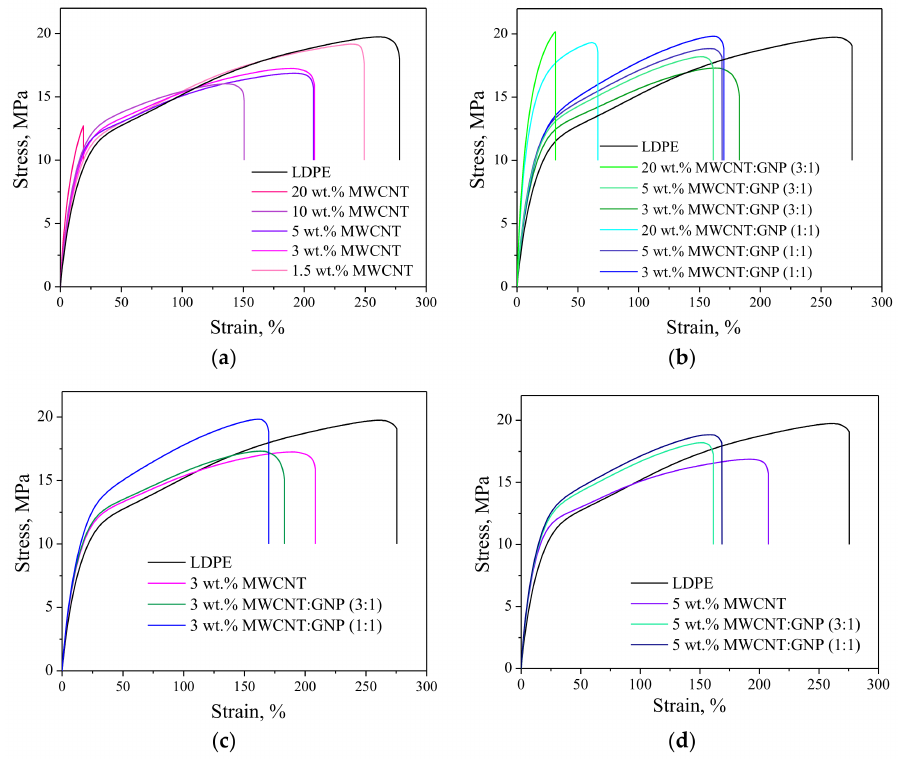
Figure 8. Stress-strain curves for ( a ) LDPE/MWCNT nanocomposites; ( b ) LDPE/MWCNT +